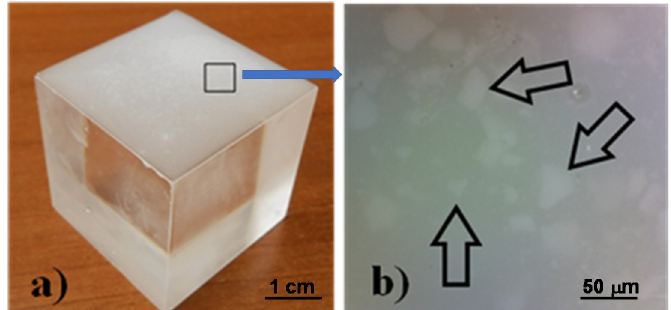
Figure 5. Surface of a CsI(Tl) scintillator coated by a reflective layer of Technovit Epox resin filled with PTFE nanopowder ( a ). An optical micrograph of the achieved surface microstructure, where the arrows indicate the aggregates present in the coating layer ( b ).